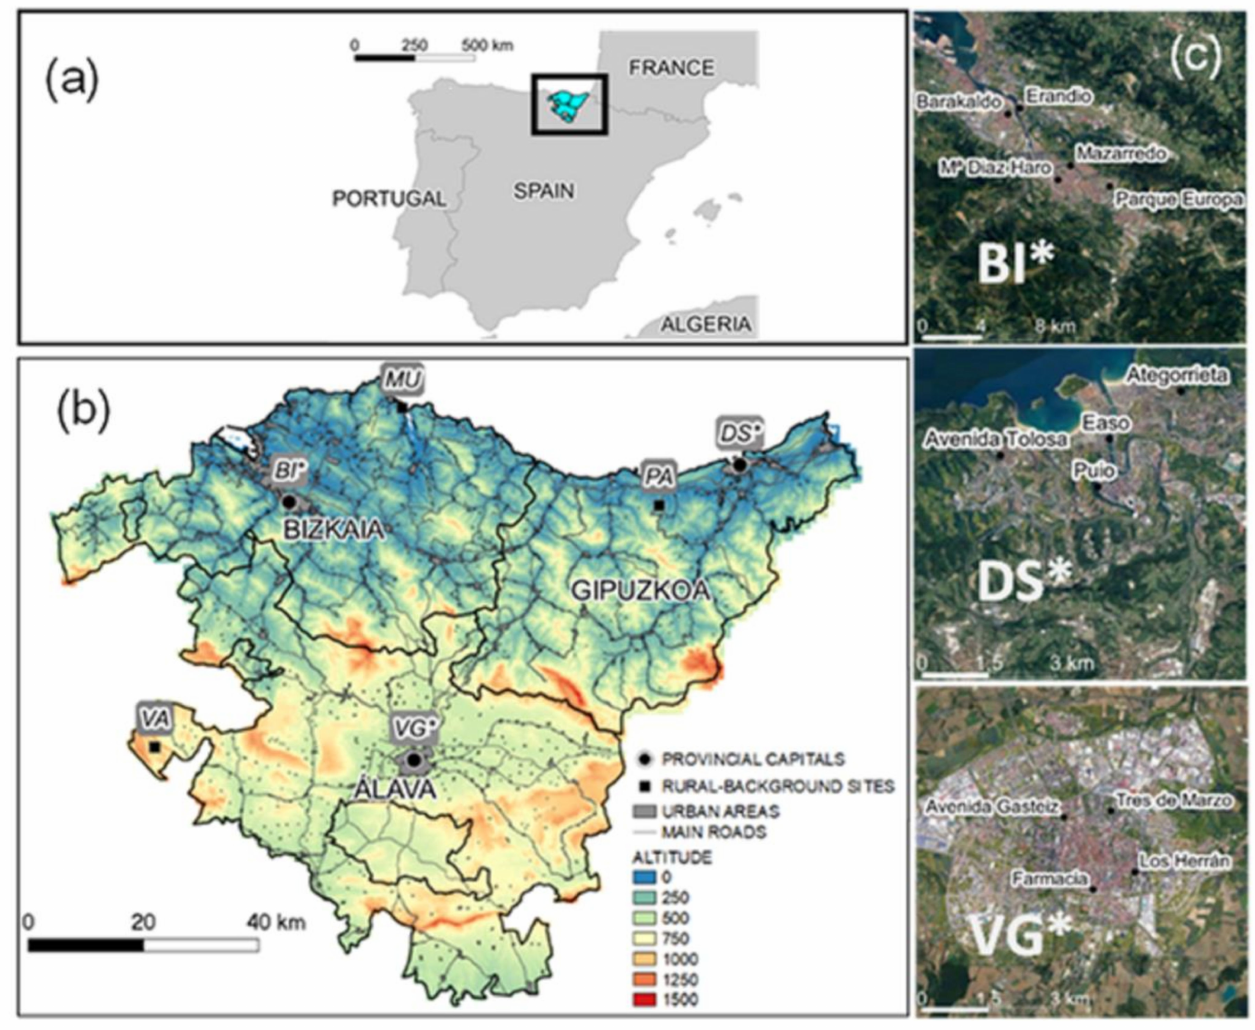
Figure 1. ( a ) Location of the Basque Country in Spain; ( b ) Topographic map. Colored scale indicates altitude (m) above the mean sea level (a.m.s.l.), bold lines separate the provinces (Bizkaia, Gipuzkoa, and Alava), main urban areas are shaded in gray and main roads are marked with thin solid lines. Measurement sites correspond to provincial capitals, clustered urban sites: Bilbao (BI*), Donostia-San Sebastian (DS*), and Vitoria-Gasteiz (VG*), and rural sites: Mundaka (MU), Pagoeta (PA), and Valderejo (VA); ( c ) Monitoring sites for each clustered urban traffic station (BI*, DS*,